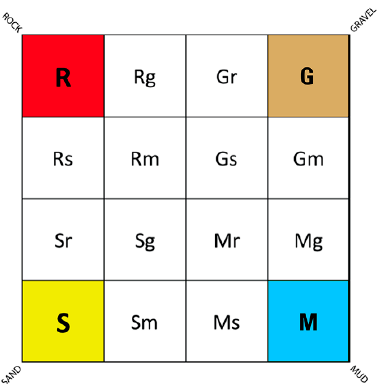
Figure 3. Barnhardt and others (1998) [66] bottom-type classification based on four end-member sediment units: rock (R), gravel (G), sand (S), and mud (M). Twelve additional two-part units represent combinations of the four basic units. In the two-part (composite) units, the primary texture (greater than 50% of the area) is given an uppercase letter and the secondary texture (less than 50% of the area) is given a lowercase letter. Figure is modified from [66].